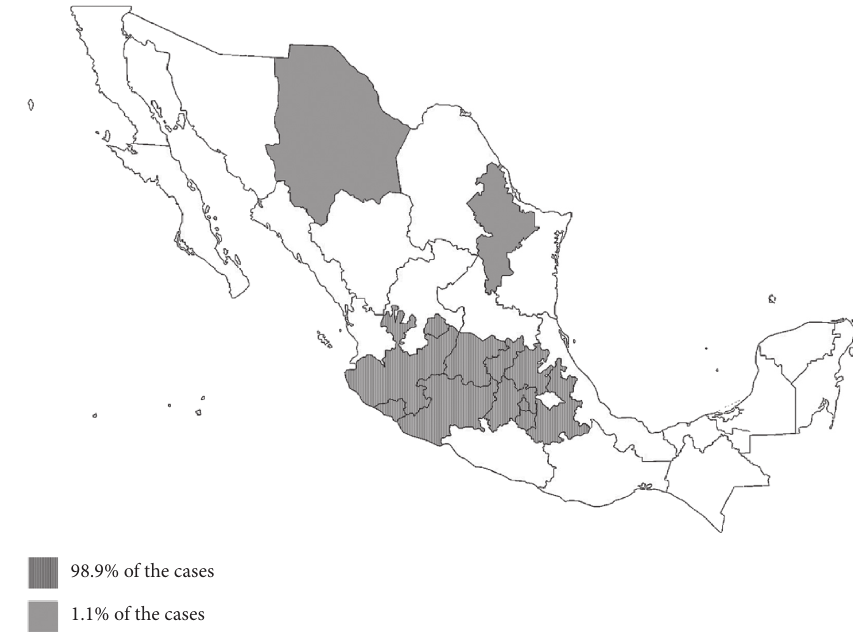
Figure 1: Geographic distribution of cases of silica urolithiasis in Mexico. Table 2: Risk by age group.